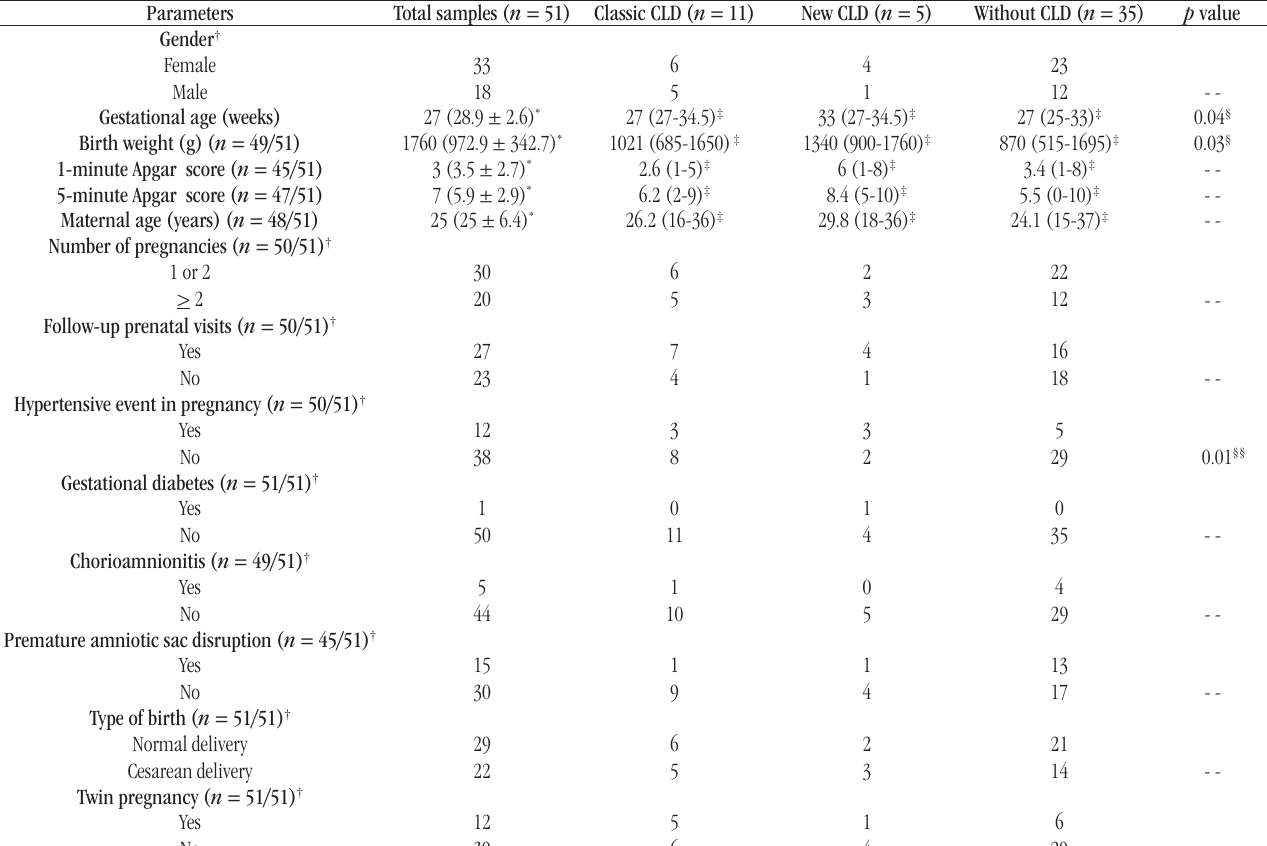
taBLE 2 − Clinical data for the three